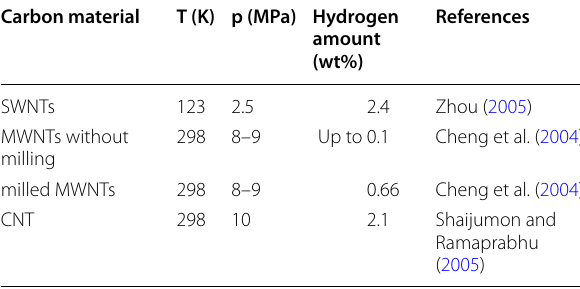
Table 3 Experimentally reported hydrogen storage capacities in carbon